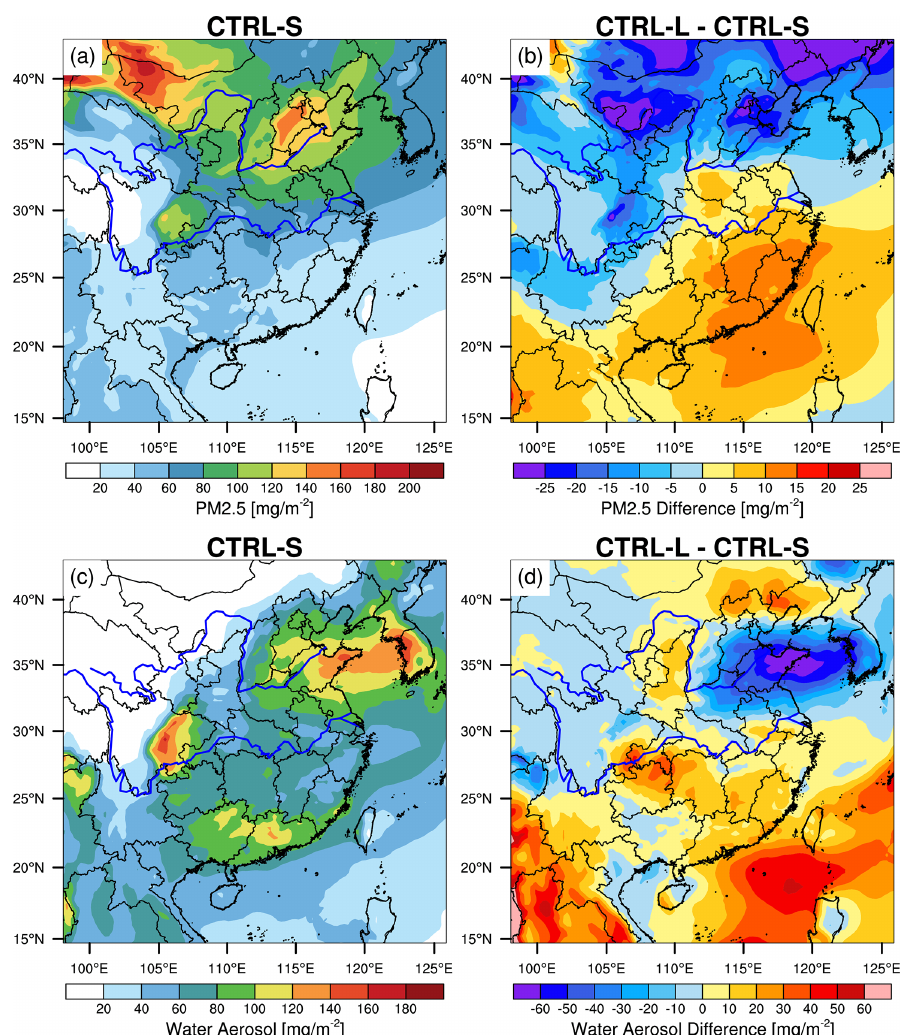
Figure 6. The spatial distributions of column integrated total (a) PM 2 . 5 concentration and (c) water content in aerosols averaged for June and July 2017 from the CTRL-S simulation, and (b, d) the difference between CTRL-L and CTRL-S.